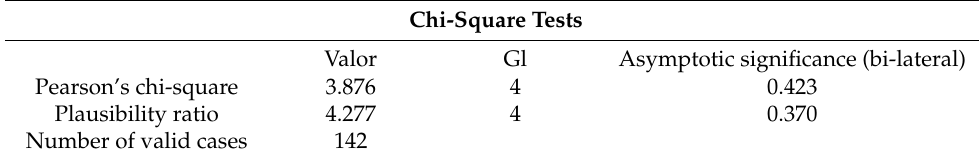
Table 2. This table shows the statistical association between the variable sex and suture maturation.